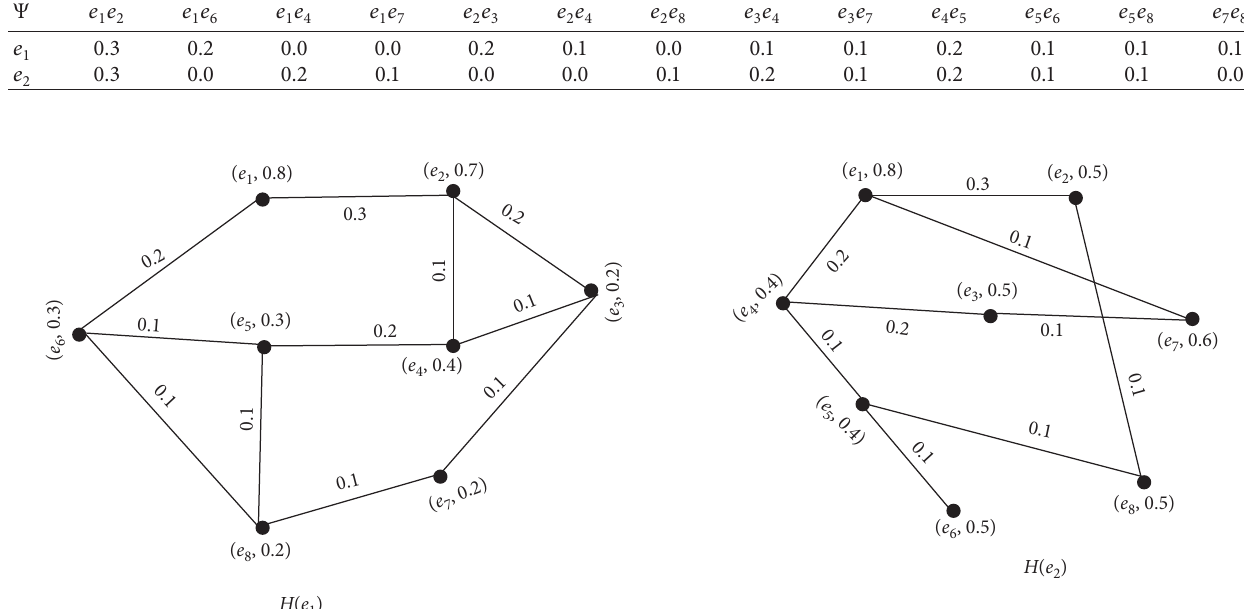
Figure 30: Fuzzy soft graph G � H ( e